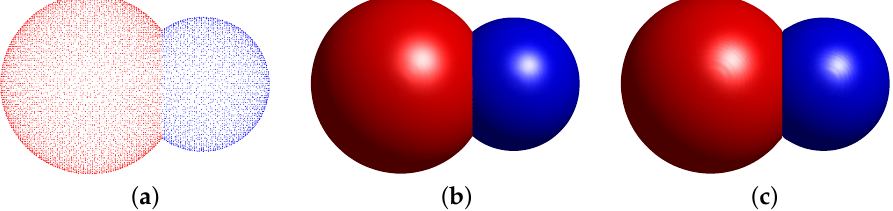
Figure 3. ( a ) The point cloud that is downsampled for display. ( b , c ) The surfaces that are obtained by Poisson surface reconstruction and our method, respectively.